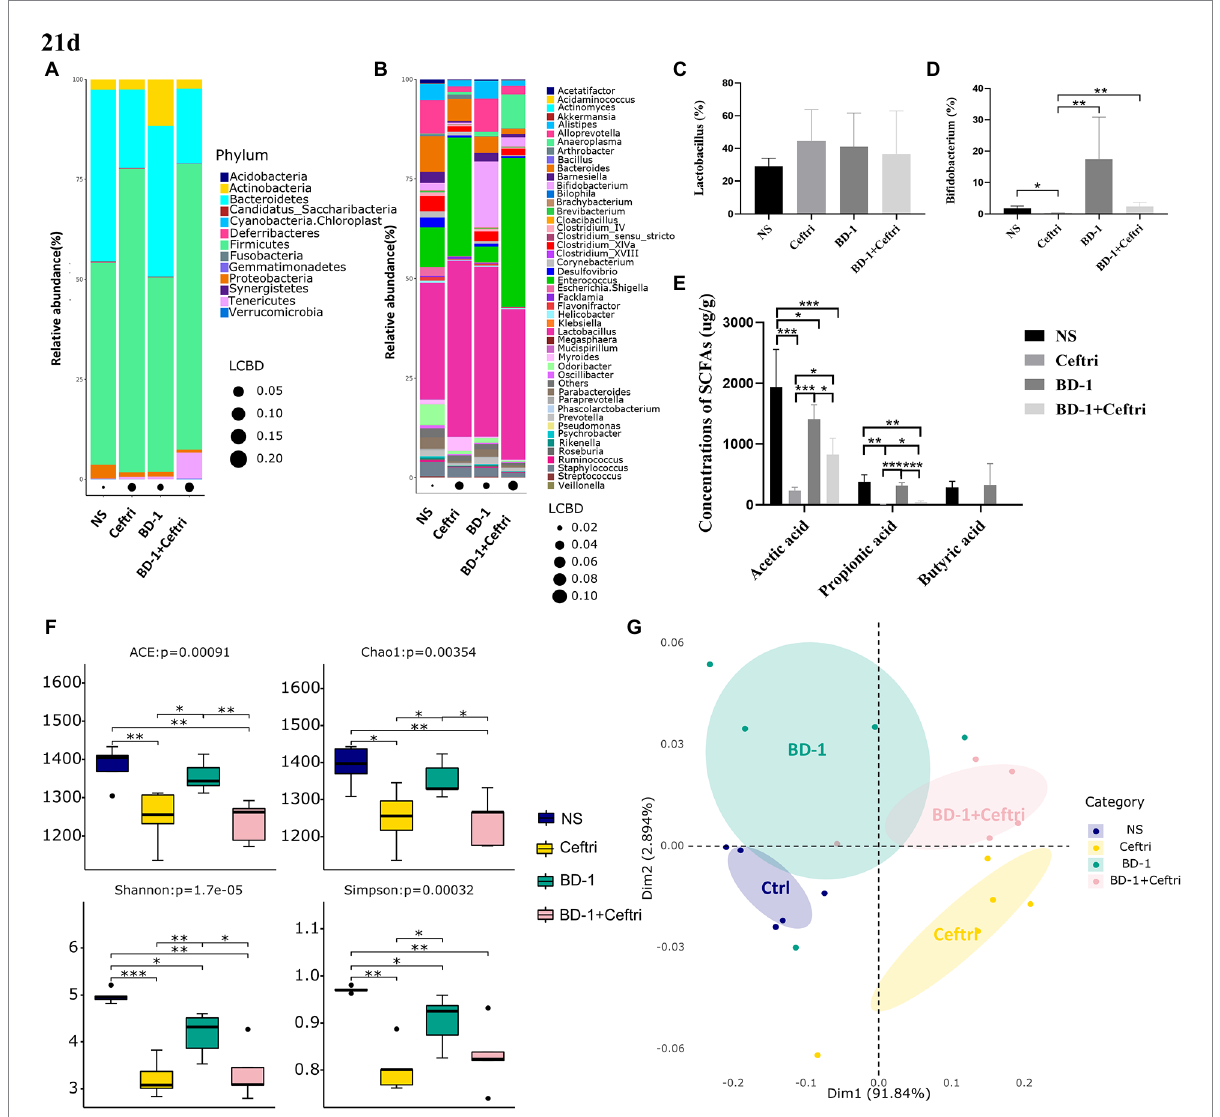
FIGURE 5 Effects on gut microbiota and metabolites after early life intervention (21 days). (A) Relative abundance at the phylum level ( n = 5). (B) Relative abundance at the genus level ( n = 5). (C) Relative abundance of Lactobacillus ( n = 5). (D) Relative abundance of Bifidobacterium ( n = 5). (E) Concentrations of SCFAs (Acetic acid, Propionic acid, and Butyric acid, respectively; n = 6). (F) The alpha diversity of the gut microbiota ( n = 5). (G) Principal co-ordinates analysis (PCoA) plots of fecal microbiota (Adnois, p < 0.05; Betadisper, p > 0.05; n = 5). * p < 0.05, ** p < 0.01, and *** p < 0.001 as